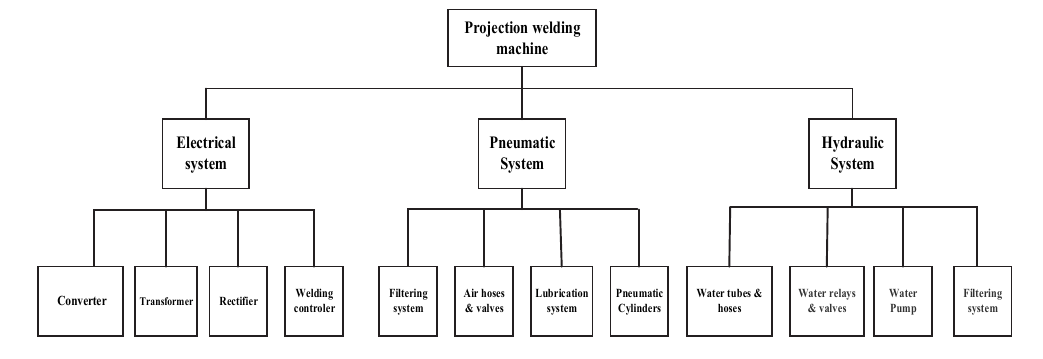
Fig. 1 . The hierarchical structure of the PSW machine under